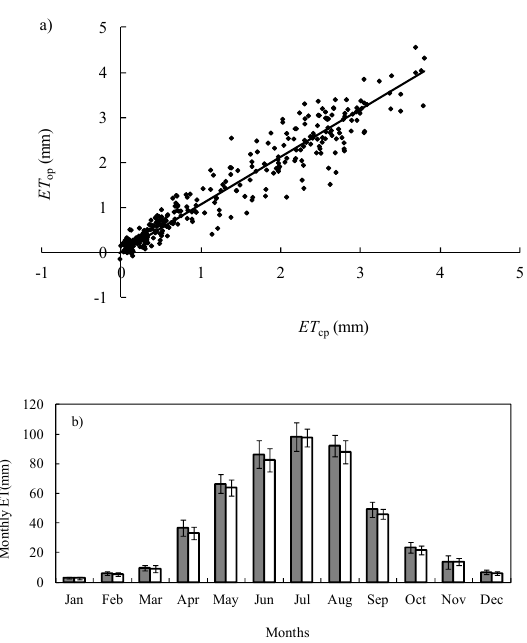
Figure 7. Energy balance closure for the OP (a) and CP system (b) . Plotted are the available energy (net radiation minus soil heat flux) on the x axis and the sum of sensible and latent heat flux on the y axis. Symbols represent half-hourly fluxes, broken lines the 1 : 1 correspondence, and solid lines linear